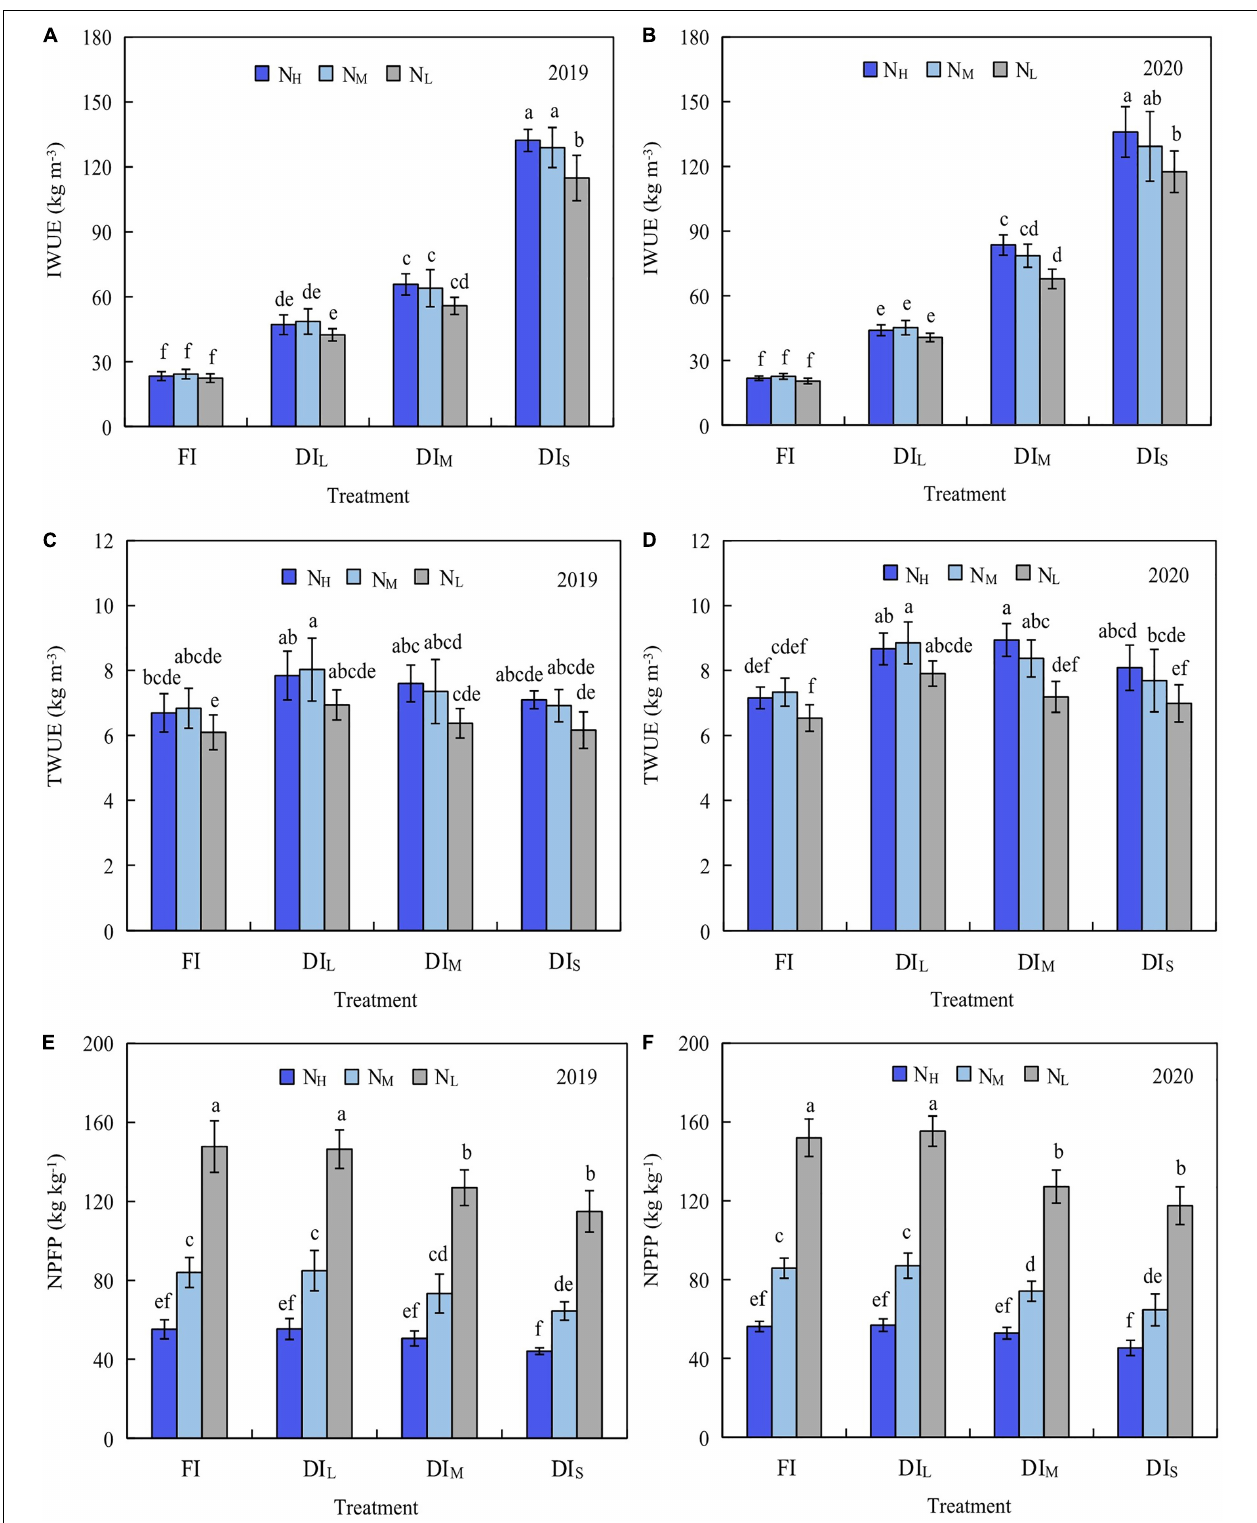
FIGURE 5 | Effects of water and nitrogen coupling on irrigation water use efficiency (2019, A ; 2020, B ), total water use efficiency (2019, C ; 2020, D ), and nitrogen partial factor productivity (2019, E ; 2020, F ) of mountain apple. Different letters above the bars indicate a significant difference at P < 0.05 according to the Duncan test. FI, DI L , DI M , and DI S are full irrigation, light deficit irrigation, moderate deficit irrigation, and severe deficit irrigation, respectively. N H , N M , and N L are high nitrogen, medium nitrogen, and low nitrogen, respectively. Bars and errors stand to represent mean ± standard deviation.